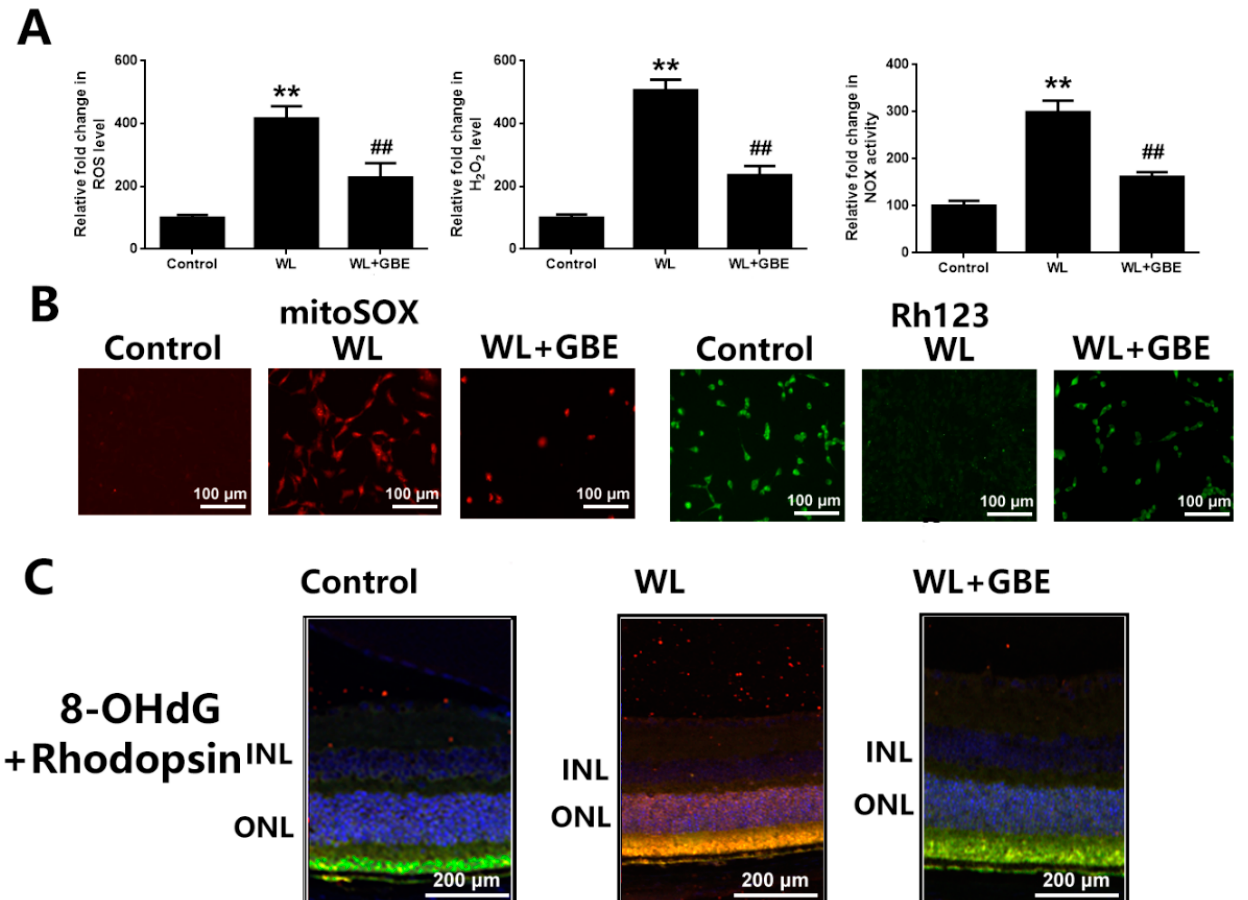
Figure 3. The antioxidative effect of GBE in 661W cells and C57BL/6J mice exposed to WL illumination. ( A ) Cells from the 661W cell line pre-treated with GBE (100 mg/L, 24 h) were exposed to WL (4000 lux) for 30 min. The level of intracellular ROS was assessed by DCFH-DA staining (left panel) and that of intracellular H 2 O 2 was analyzed by titanium sulfate colorimetry (middle panel). The activity of NOX was evaluated using DCPIP assay (right panel). ( B ) The 661W cells pre-treated with GBE (100 mg/L, 24 h) were exposed to WL (4000 lux) for 2 h. The level of mitochondrial ROS was assessed using mitoSOX staining (left panel) and that of MMP was assessed using rhodamine123 staining (right panel). ( C ) Retinal tissues from mice with the indicated treatments were co-stained with DAPI (blue fluorescence), 8-OHdG (an ROS marker—red fluorescence) and rhodopsin (green fluorescence). ** p < 0.01 vs. Control, ## p < 0.01 vs. WL. WL: white light, DCFH-DA: 2,7-dichlorodihydrofluorescein diacetate, DCPIP: 2,6-dichlorophenol-indophenol, mitoSOX: mitochondrial superoxide indicator, MMP: mitochondrial membrane potential analysis, Rh123: rhodamine123, 8-OHdG: 8-Hydroxy-2 (cid:48) -deoxyguanosine, INL: inner nuclear layer, ONL: outer nuclear layer.